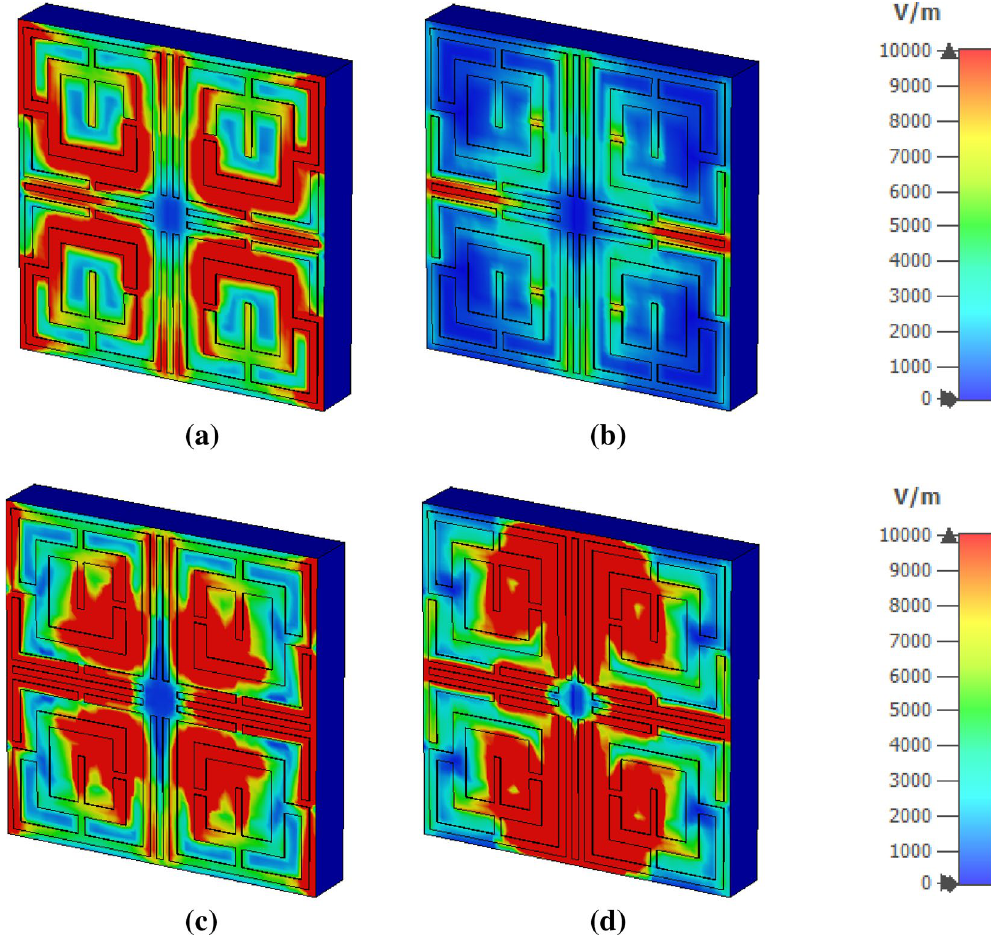
Figure 18. Electric field distribution: ( a ) 4.2 GHz, ( b ) 10.14 GHz, ( c ) 13.15 GHz, and ( d ) 17.1 GHz (CST STUDIO SUITE 2019, https:// www. 3ds. com/ produ cts- servi ces/ simul ia/ produ cts/ cst- studio- suite) 42 .